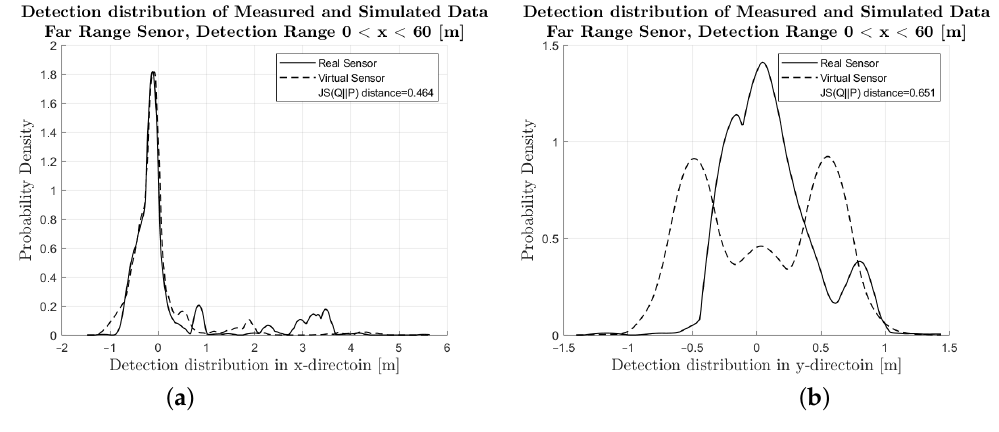
Figure 11. Evaluation of the detections in the range of 0 to 60 m of the far-range radar sensor and sensor model. ( a ) PDF of the deviation in the x -direction from P ref ( x , y ) of the real sensor and sensor model. ( b ) PDF of the deviation in the y -direction from P ref ( x , y ) of the real sensor and sensor model.